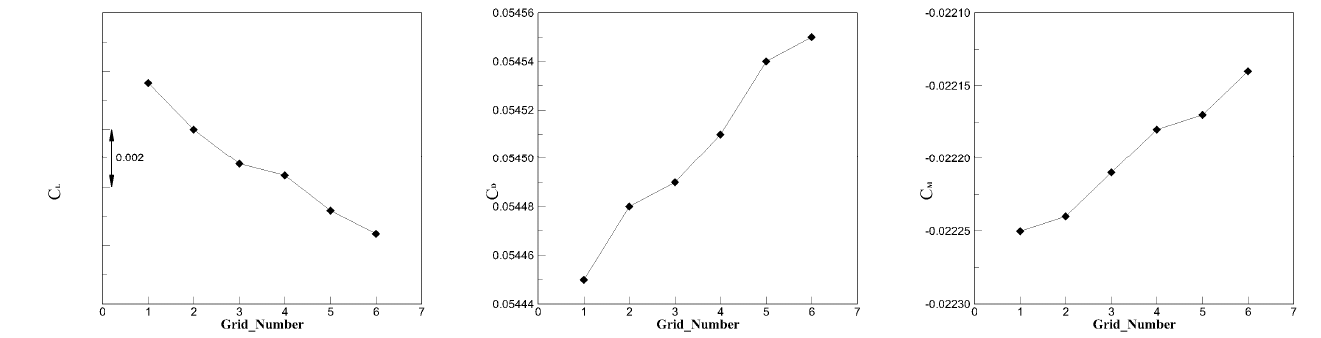
Figure 4. Aerodynamic forces coefficients of the grid convergence.